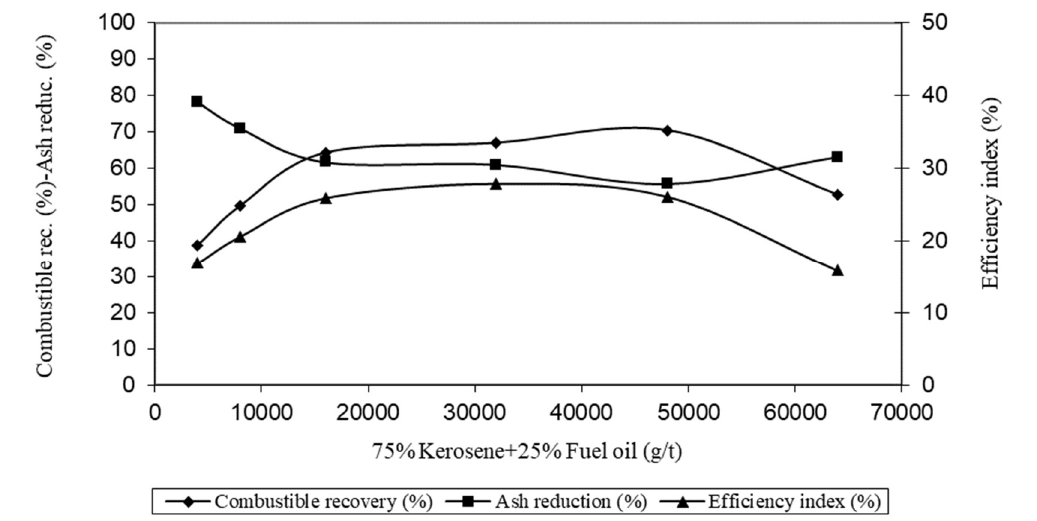
Fig.7 . Effect of 75% kerosene + 25% fuel oil concentration on combustible recovery, ash reduction and efficiency